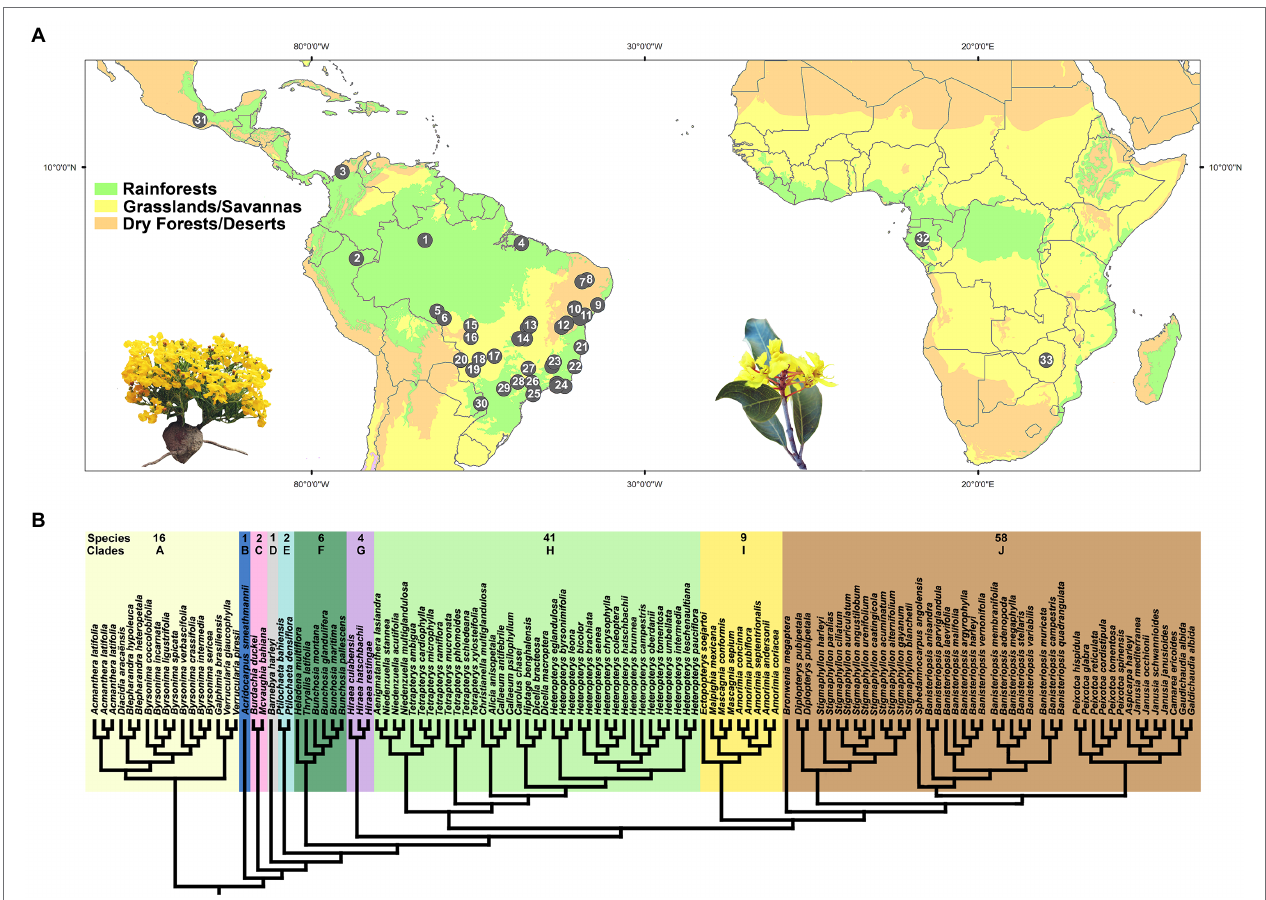
FIGURE 2 | (A) Distribution map showing the collection sites of all samples within the American and African continents. A complete record of all collection sites (numbers on black circles) is listed in Supplementary Table 1 . Photograph on the left represents a New World tropic species of Malpighiaceae ( Camarea ericoides by R.F. Almeida). Photograph on the right represents an Old World tropic species of Malpighiaceae ( Acridocarpus excelsus by T. Randrianarivony). (B) Ten major phylogenetic clades currently accepted in Malpighiaceae, based on plastid and nuclear genes, according to Davis and Anderson (2010). Major clades are shaded in different colors. Species = number of species sampled by each clade in our study. Clade A, Byrsonimoid clade; B, Acridocarpoid clade; C, Mcvaughioid clade; D, Barnebyoid clade; E, Ptilochaetoid clade; F, Bunchosioid clade; G, Hiraeoid clade; H, Tetrapteroid clade; I, Malpighioid clade; and J, Stigmaphylloid